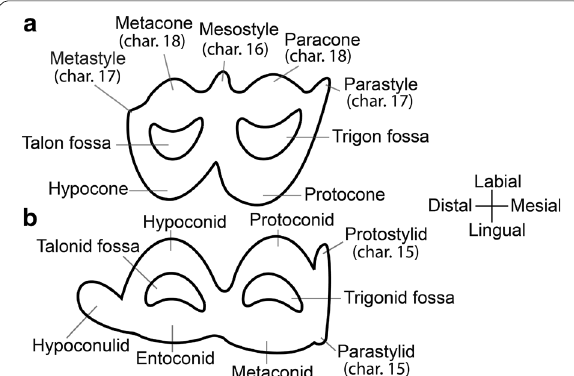
Fig. 3 Schematic drawings of L. guanicoe ’s teeth. a M 3 , occlusal view. b M 3 , occlusal